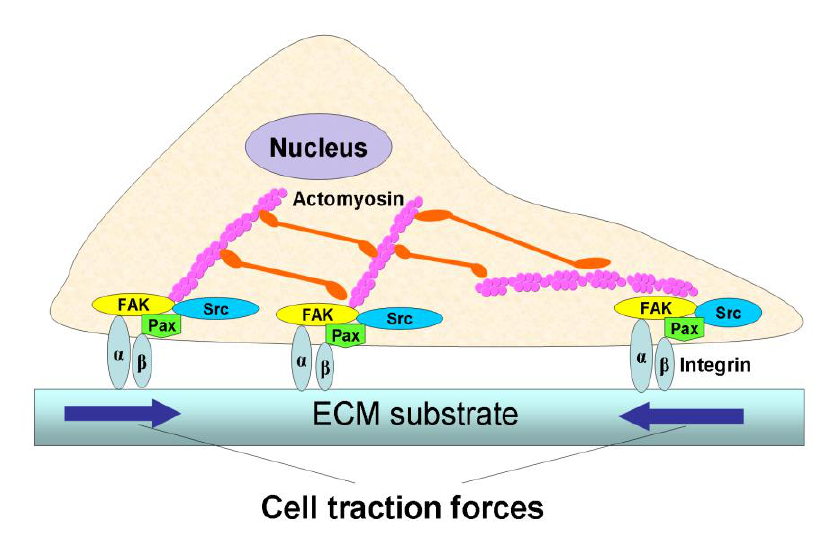
Figure 1. An illustration of the generation and transmission of cell traction forces (CTFs). The actomyosin interactions in the cell generate intracellular tension, which is then transmitted to an underlying substrate through focal adhesions consisting of integrins and other structural and signaling proteins (not shown). The resulting forces, shown by two arrows in opposite directions, are CTFs (adapted with permission from Figure 1 in